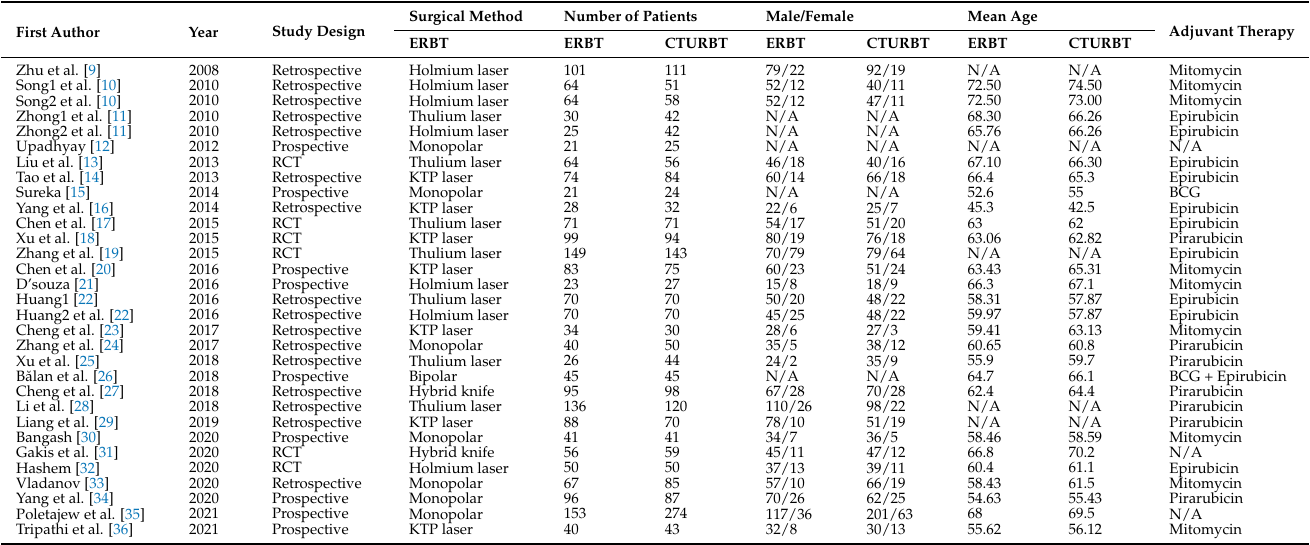
(Figure 3d), the ERBT had a lower rate than the TURBT group (OR 0.28; 95% CI = 0.15 to 0.52; I 2 = 0%; p value < 0.001). Table 1. The general characteristics of studies included in this article. RCT, randomized controlled trial; KTP laser, Potassium-Titanyl-Phosphate laser; N/A, not available.